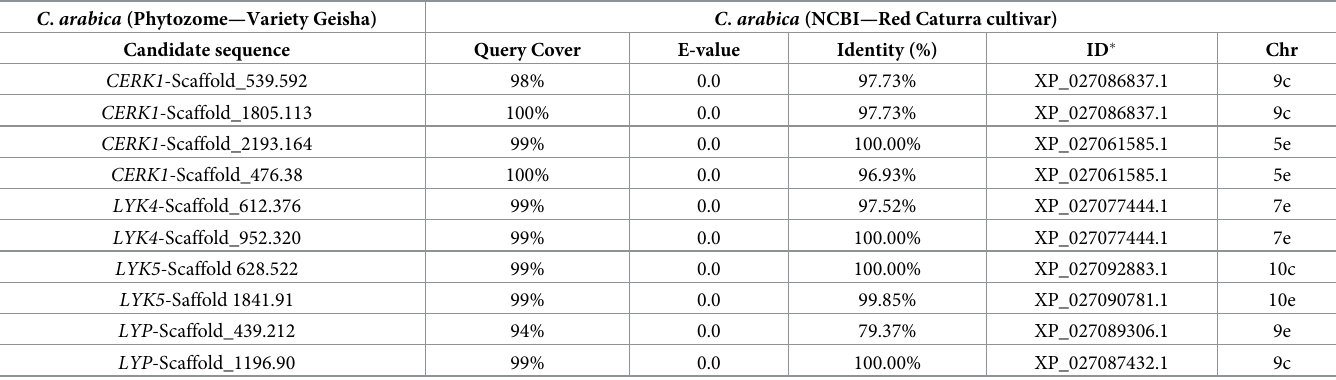
Table 4. BLASTp analysis of candidate sequences in C . arabica (Geisha) against C . arabica (Red